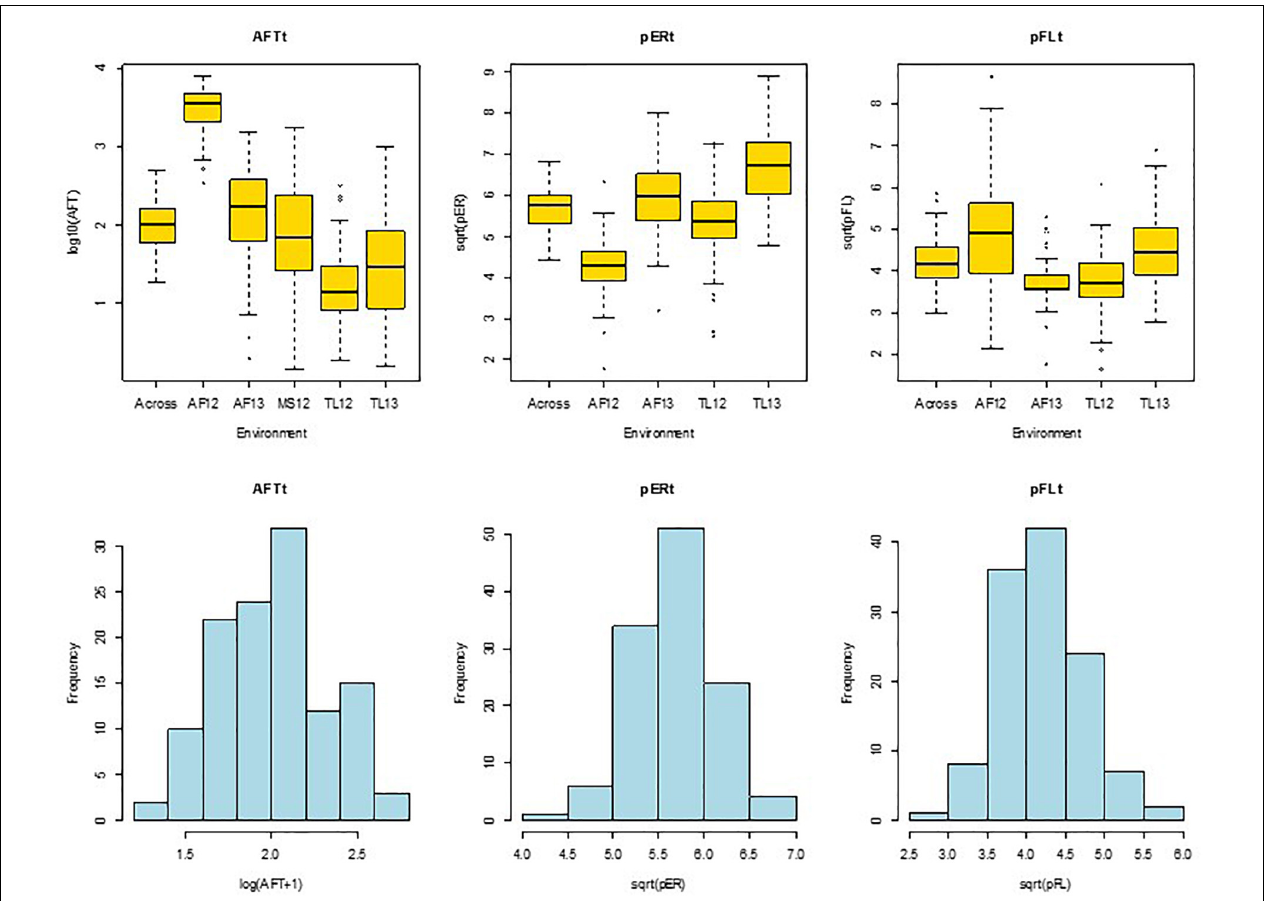
FIGURE 1 | Quartile distribution box plots (upper) and histograms (lower) of hybrid means for aflatoxin concentration in grain [AFTt, log(AFT+1)], A. flavus ear rot symptom scores [pERt, sqrt(pER)], and A. flavus colonization of grain measured by bright greenish yellow fluorescence scores [pFLt, sqrt(pFL)]. Across, across environments; AF12, AF13, Agua Fria, 2012 and 2013; TL12, TL13, Tlaltizapan 2012 and 2013; MS12, Mississippi 2012.